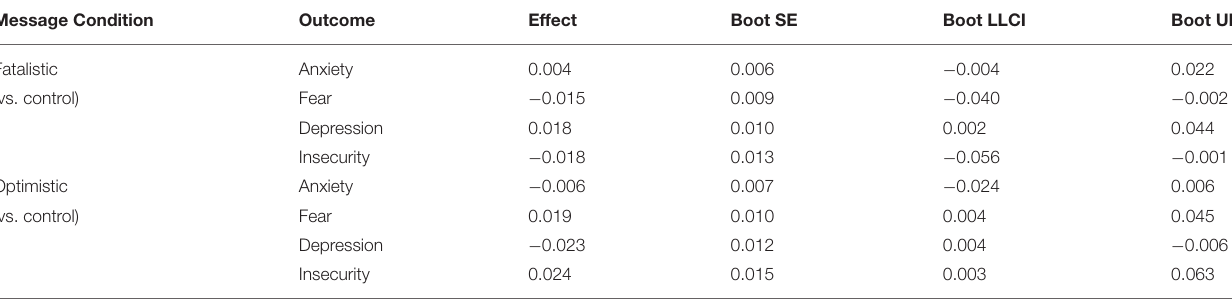
TABLE 4 | Indirect effects of messaging condition on negative emotions through COVID-19